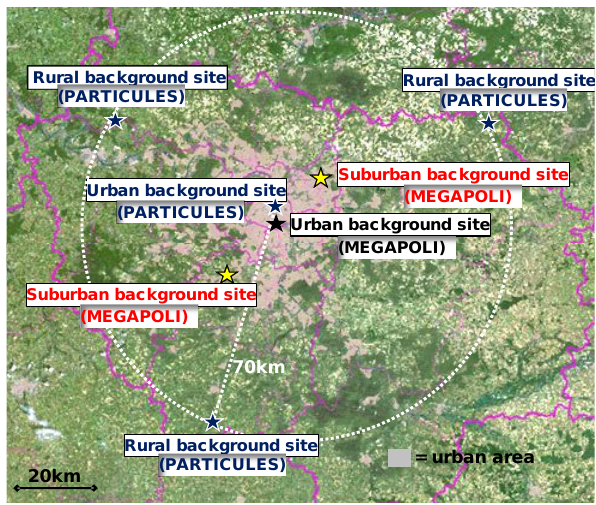
Figure 1. Location of the sampling sites from the MEGAPOLI and PARTICULES projects in the Ile-de-France region. The zone in beige color stands for the urban area of the Paris agglomeration. The white circle shows the three rural background sites, all at about 70km distance from the PARTICULES urban background site. The purple lines indicate administrative boundaries. Map source: Google